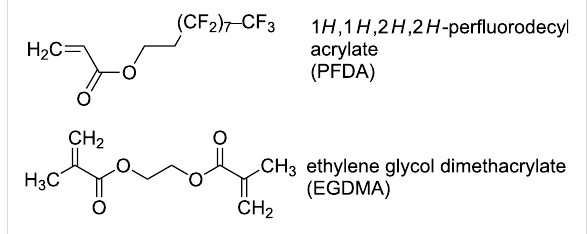
Figure 1: Molecular structure of the monomers PFDA and